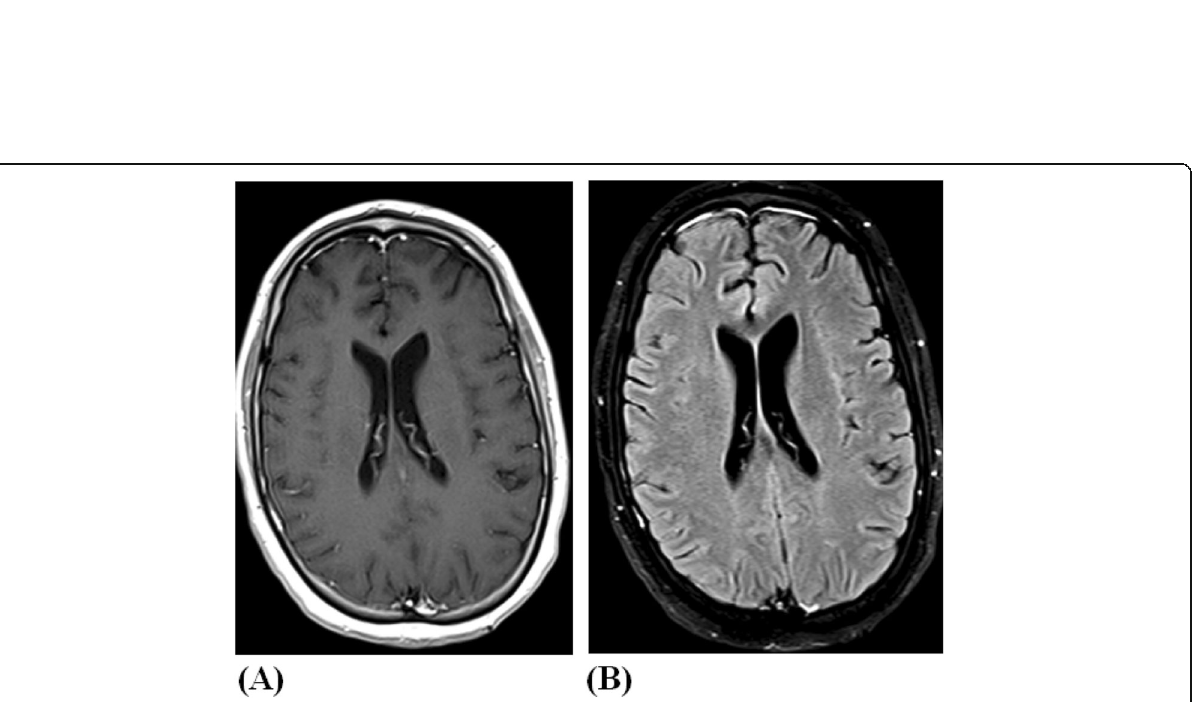
Fig. 2 Axial contrast-enhanced MRI, ( a ) T1 WI mild diffuse meningeal enhancement. Contrast-enhanced FLAIR ( b ) shows meningeal enhancement obvious mainly at both frontal